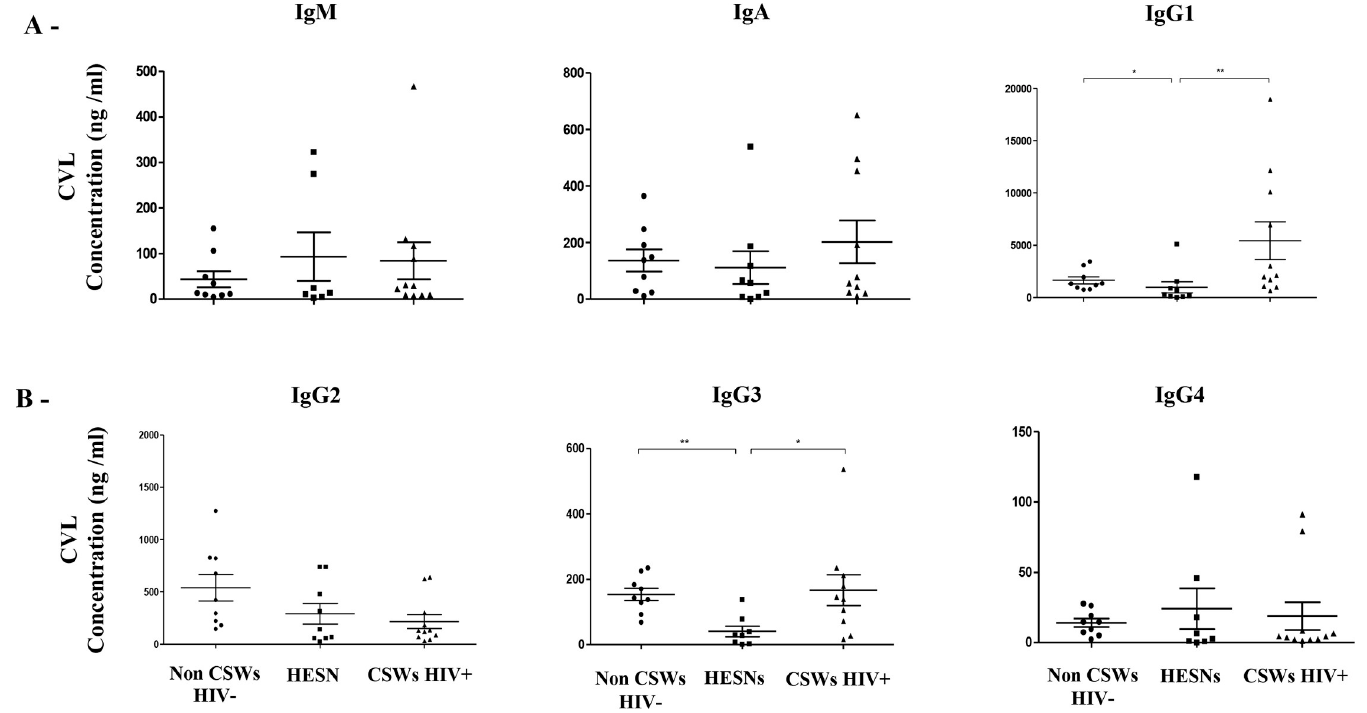
Fig 5. Total immunoglobulin (Ig) isotypes concentrations in cervicovaginal lavage (CVL) supernatants of HIV-1 uninfected non-CSW, HESN and HIV-1 infected CSW women. Immunoglobulin (A) M, A, G1 and (B) G2, G3, G4 isotypes concentrations (ng/ml) in CVLs were compared with Mann Whitney U test for pair-wise comparisons between HESNs and the two other groups. Data are presented as mean ± SD. Significance levels are shown as � (p < 0.05), �� (p < 0.01), ��� (p < 0.001). HIV, human immunodeficiency virus; CSWs, commercial sex workers; HESN, HIV Highly-Exposed Seronegative. SD, standard deviation.